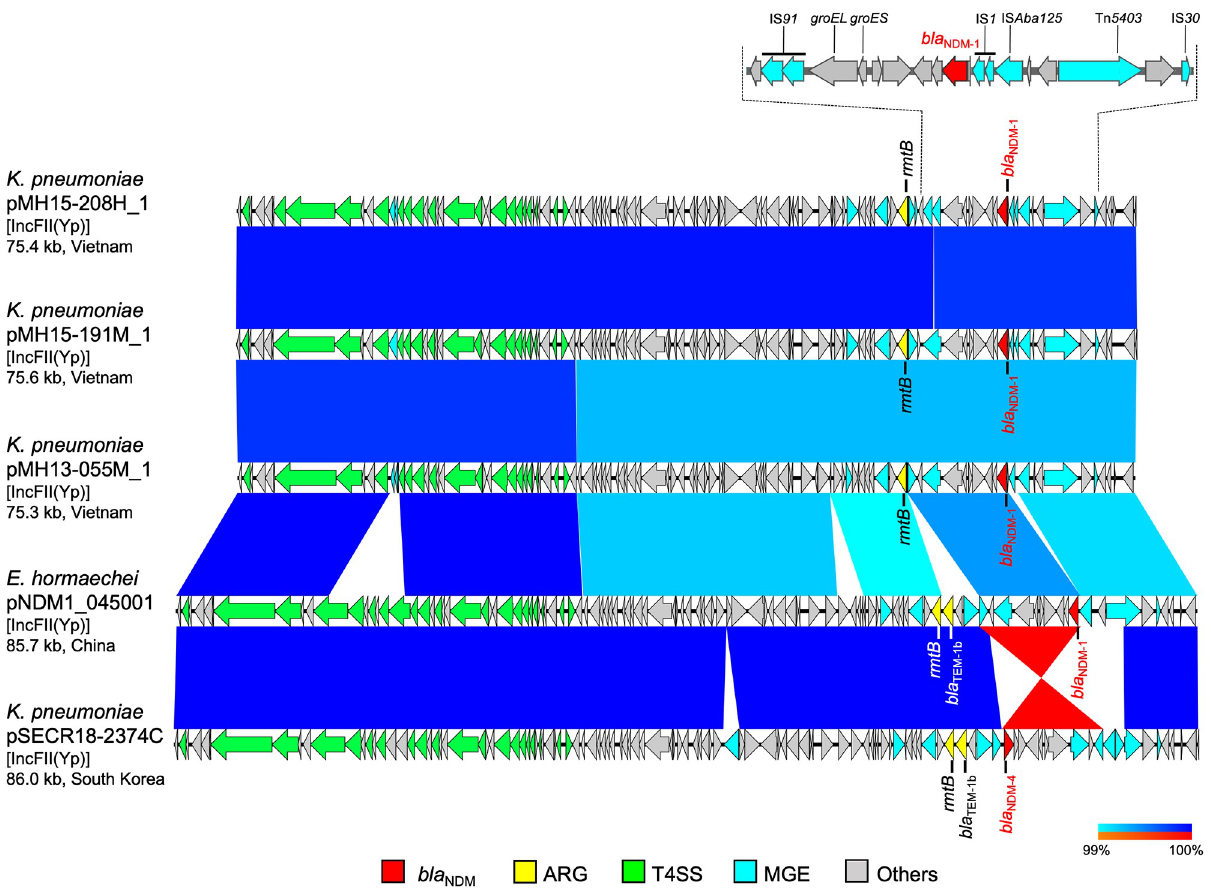
Fig 5. Linear comparison of bla NDM -carrying plasmid sequences and the detailed genetic structures around bla NDM-1 from Vietnam and other countries. K . pneumoniae pMH15-208H_1 (this study, accession: AP018580), K . pneumoniae pMH15-191M_1 (this study, accession: AP018581), K . pneumoniae pMH13-055M_1 (this study, accession: AP018582), E . hormaechei pNDM1_045001 (accession: CP043383), and K . pneumoniae pSECR18- 2374C (accession: CP041930) are shown. Red, yellow, green, blue, and gray arrows indicate bla NDM , other important AMR genes (ARGs), type IV secretion system (T4SS)-associated genes involved in conjugation, mobile gene elements (MGEs), and other genes, respectively. The colors in comparison of plasmids show percent identity and sequence direction as indicated. Blue for matches in the same direction and red for matches in the inverted